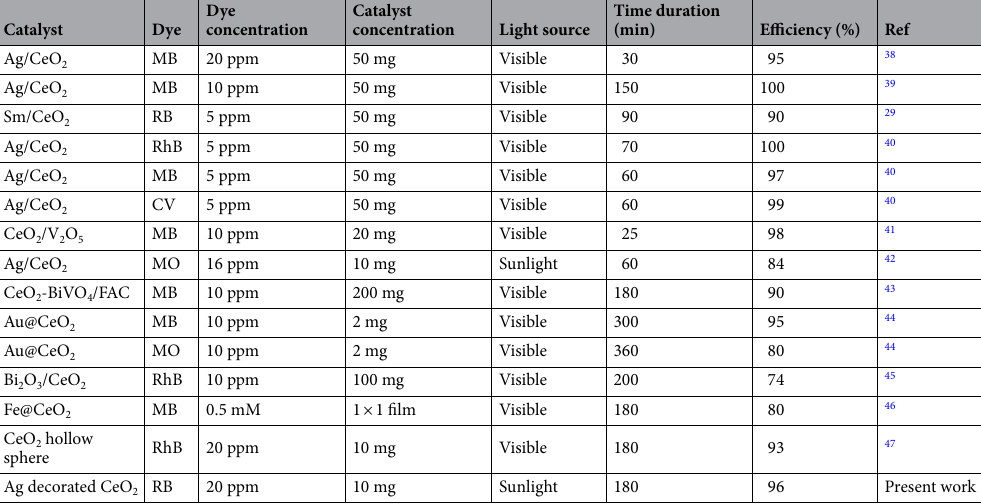
Table 2. Comparison of current and reported studies of various CeO 2 based